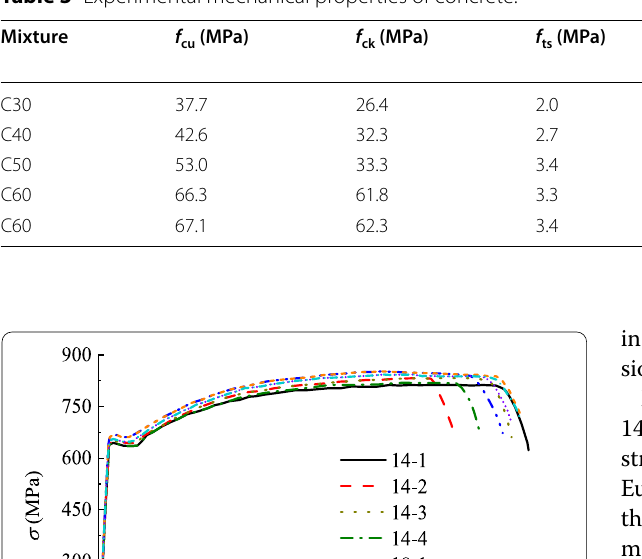
Table 3 Experimental mechanical properties of concrete.